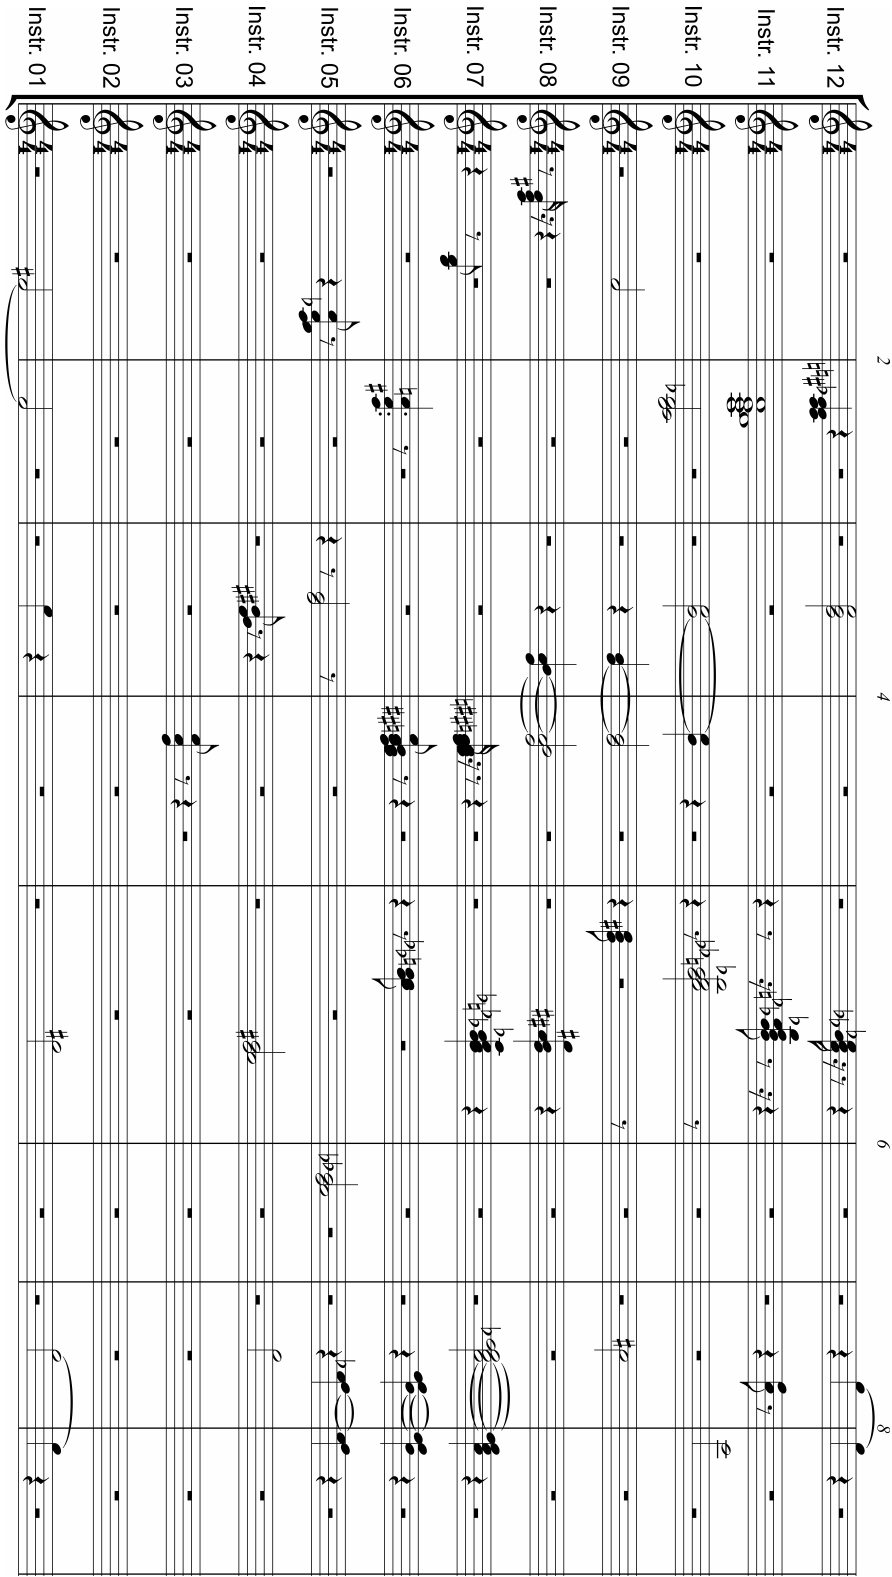
Figure 37. Resulting musical form for twelve